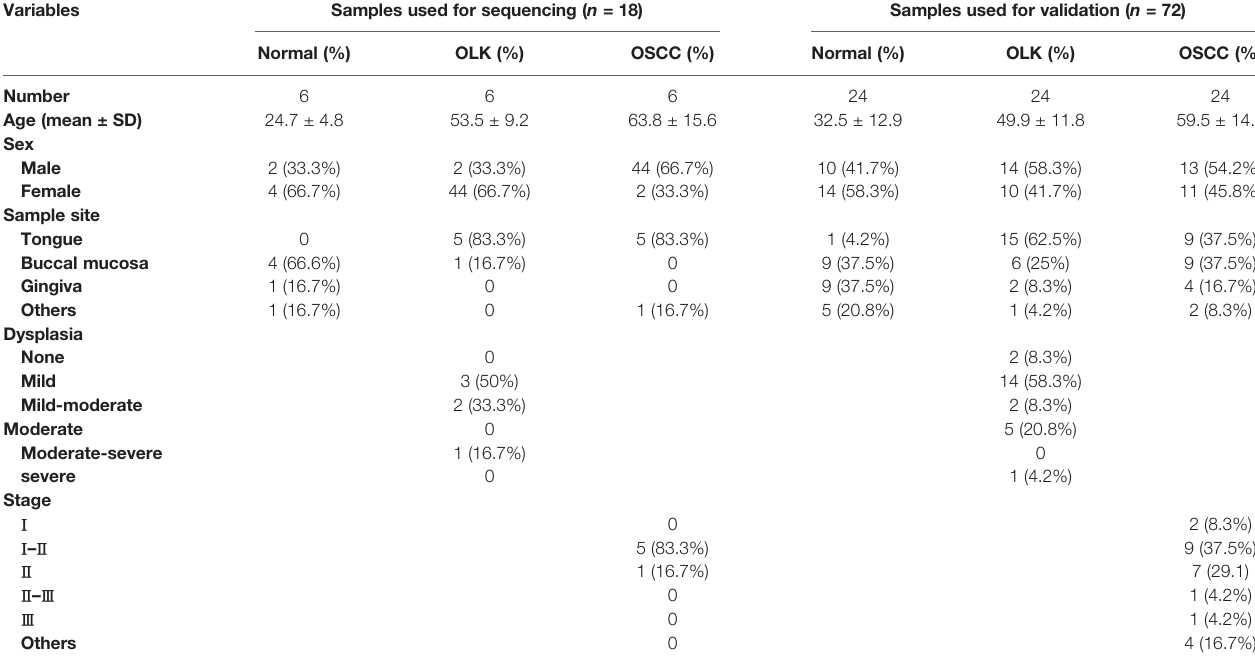
TABLE 1 | Clinical characteristics of study subjects. Variables Samples used for sequencing ( n =